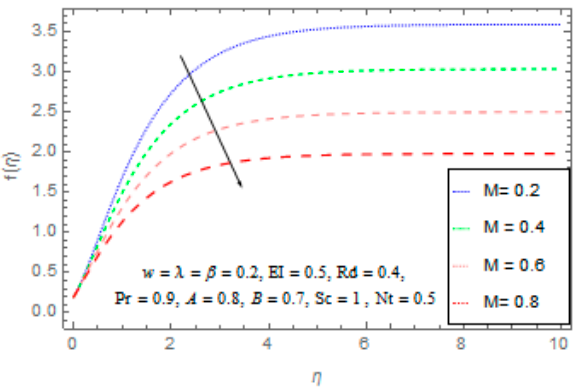
Figure 4. Influence of λ on ( ) θ η .